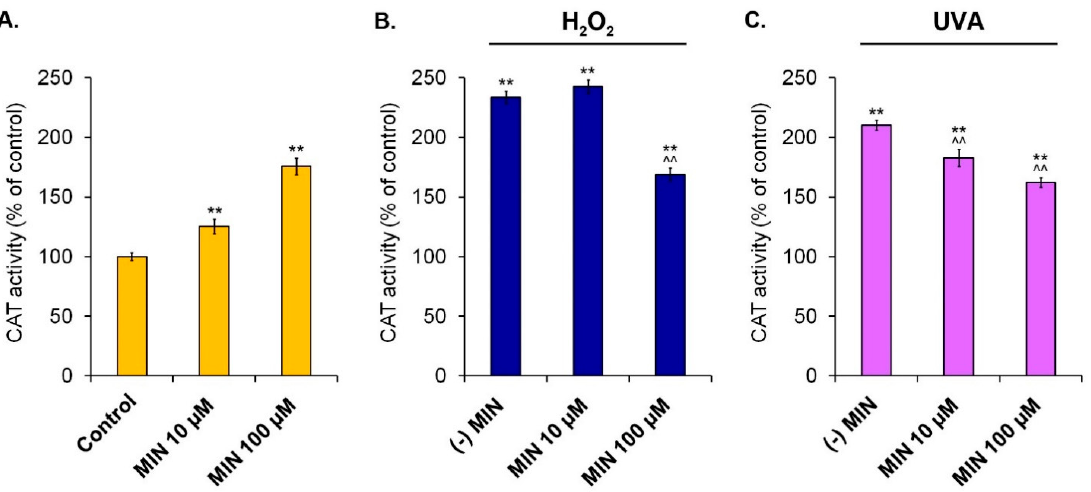
Figure 7. Changes of catalase activity in human normal melanocytes treated with minocycline ( A ) as well as additionally exposed to hydrogen peroxide ( B ) or irradiated with UVA ( C ). ** p < 0.005. vs. control; ^^ p < 0.005. vs. (-) MIN.